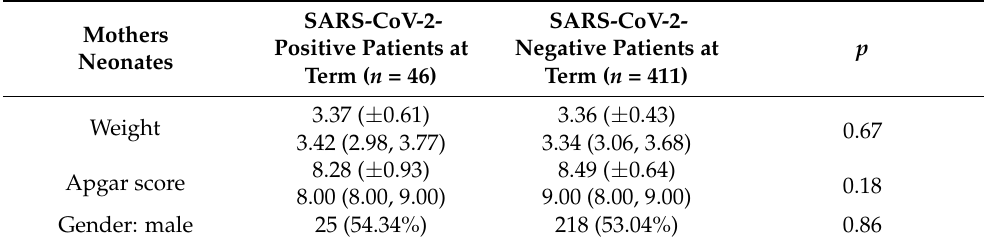
Table 15. Neonate characteristics: mean values (and standard deviation) on the upper line, and median values (quartile 1, quartile 2) on the lower line of each value below, in neonates from pregnant SARS-Cov-2-positive patients at term compared to neonates from pregnant SARS-CoV-2-negative patients at